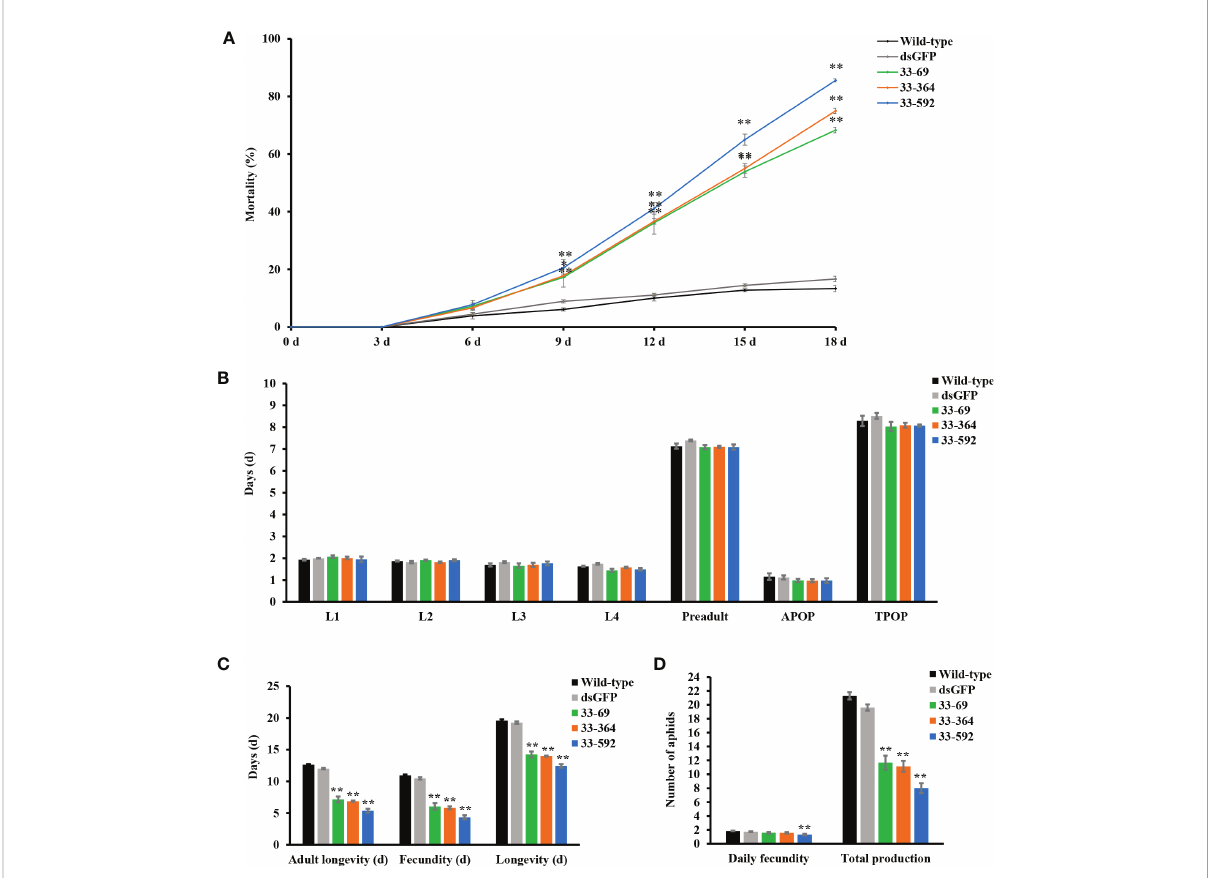
FIGURE 3 Fitness analysis of aphids fed on transgenic plants. (A) Mortality of aphids fed on wild-type and transgenic wheat lines. The mortality of aphids fed on wild-type and dsSmDSR33 expression transgenic wheat lines. Twenty synchronous one-day-old nymphs were put into clip cages individually on transgenic and wild-type wheat plants. All experiments were repeated three times. Values and bars represent the mean ± SEM (Student ’ s t -test, * P <0.05, ** P <0.01). (B) The longevity of different stages, adult preoviposition period (APOP) and total preoviposition period (TPOP) of aphids fed on transgenic lines and wild-type control. (C) The adult longevity, fecundity and the total longevity of aphids fed on transgenic wheat lines and wild-type control. (D) The reproduction of aphids fed on transgenic wheat lines and the wild-type control. All experiments were repeated three times, each with 20 synchronous one-day-old nymphs. Values and bars represent the mean ± SEM (Student ’ s t -test, * P <0.05, ** P